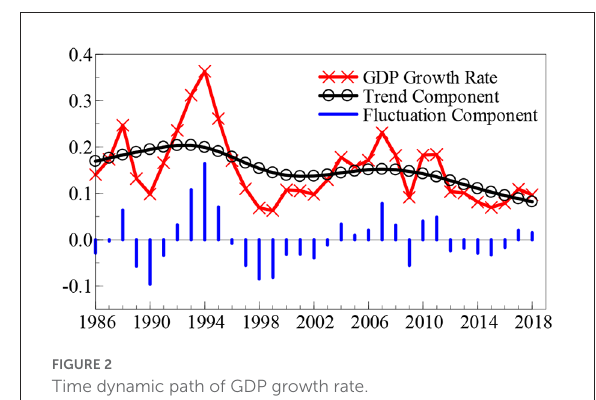
FIGURE2 Time dynamic path of GDP growth